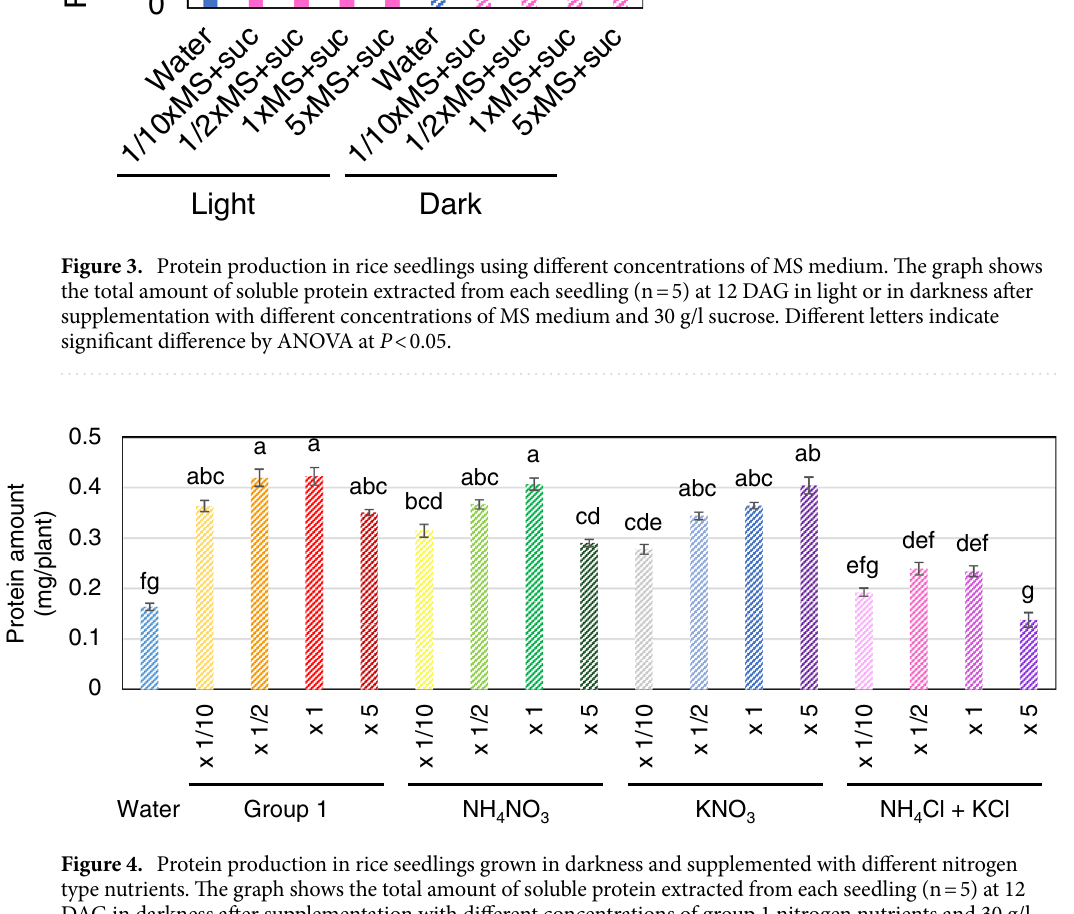
Figure 4. Protein production in rice seedlings grown in darkness and supplemented with different nitrogen type nutrients. The graph shows the total amount of soluble protein extracted from each seedling (n = 5) at 12 DAG in darkness after supplementation with different concentrations of group 1 nitrogen nutrients and 30 g/l sucrose. Different letters indicate significant difference by ANOVA at P <